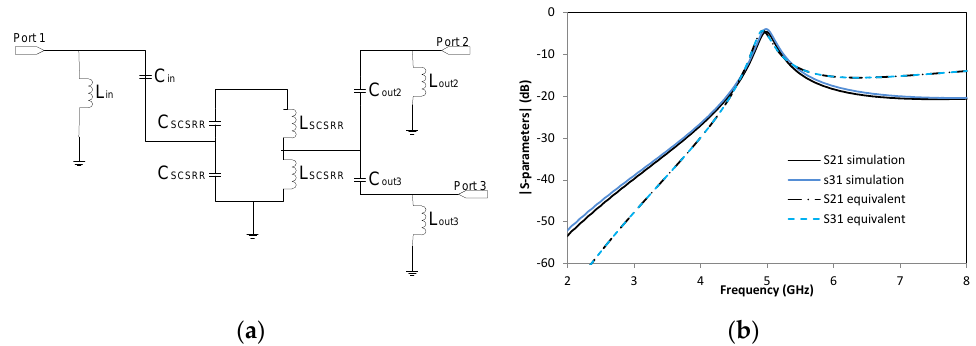
Figure 14. ( a ) Equivalent circuit model 2-layer power divider. ( b ) Simulated S21 (dashed black line) and simulated S31 (dashed blue line). Equivalent circuit S21 (dashed-dotted black line) and equivalent circuit S31 (dashed blue line).